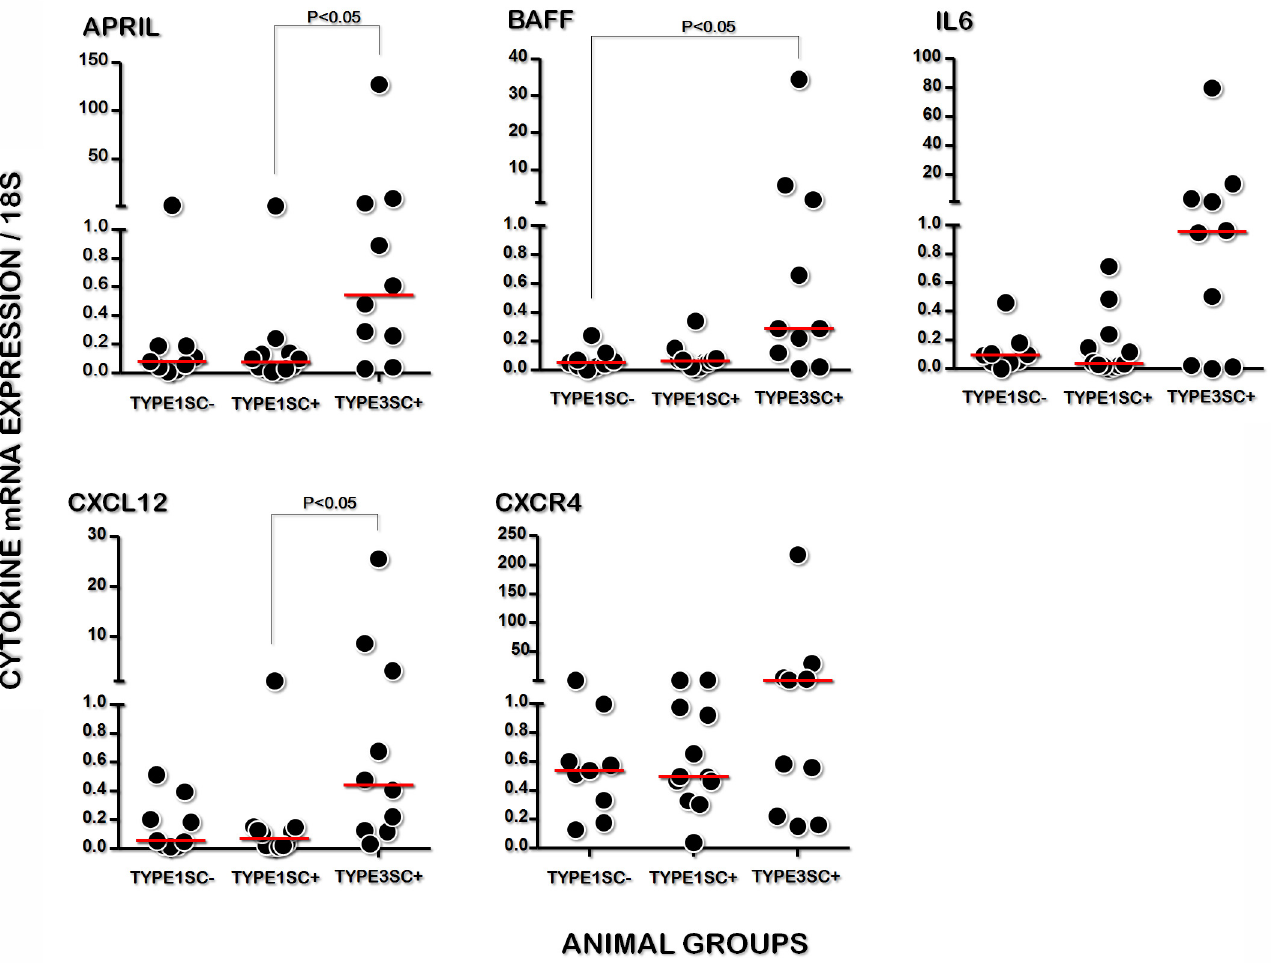
Fig 3. Gene expression of APRIL, BAFF, IL6, CXCL12 and of the CXCR4 chemokine receptor in the spleens of normal dogs, those with inactive (TYPE1SC-) or active (TYPE1SC+) Leishmania infection, or those with disorganized white pulp and active Leishmania infection (TYPE3SC+). (Kruskall-Wallis